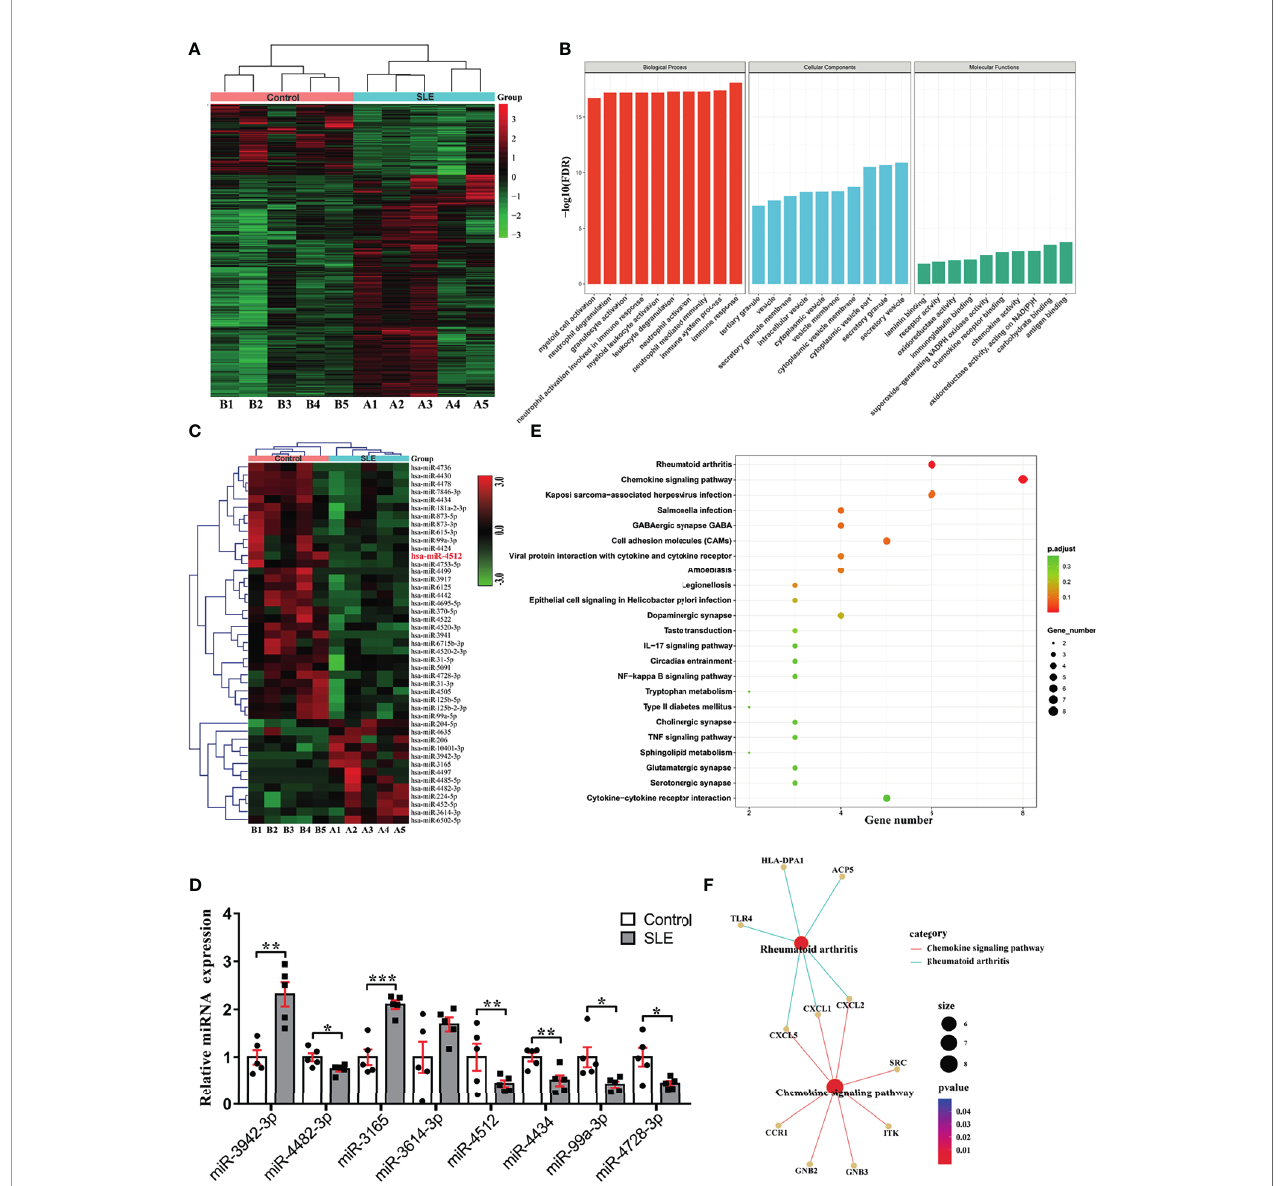
FIGURE 1 | miRNA and mRNA pro fi ling reveals potential regulatory network involved in SLE pathogenesis. (A) Heat map representation of differentially expressed genes in SLE patients and control subjects (n = 5). (B) Top 10 GO processes determined based on all differentially expressed genes highlight enrichment of neutrophil activation and chemokine activity. (C) Hierarchical clustering of 45 differentially expressed miRNAs in SLE patients and control subjects from the same cohort determined by mRNA sequencing (>2-fold change, P < 0.05). (D) The top four downregulated and upregulated miRNAs were analyzed by RT-qPCR in PBMCs from fi ve SLE patients and fi ve age- and gender-matched healthy controls. PBMC set different from that used in (C) was analyzed. Results are presented as the mean ± SEM. *** P < 0.001; ** P < 0.01; * P < 0.05. (E) KEGG analysis of predicted target genes of miR-4512. (F) The regulatory networks of miR-4512 target genes and autoimmune disease-related